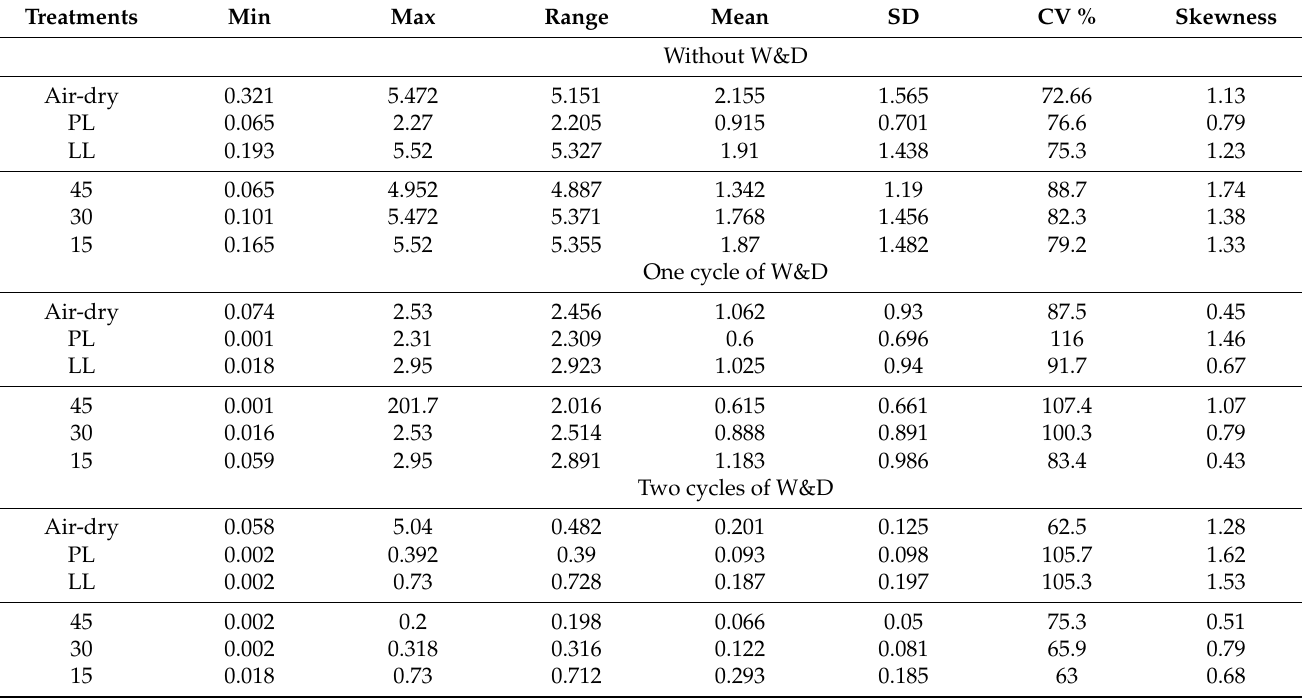
Table 2. Summary of statistics of the splash erosion rate (g m − 2 min − 1 ) for the studied clay–sand mixtures and clay soil at different water contents and clay contents (kg 100 kg − 1 ) in various wetting and drying (W&D) cycles ( N =